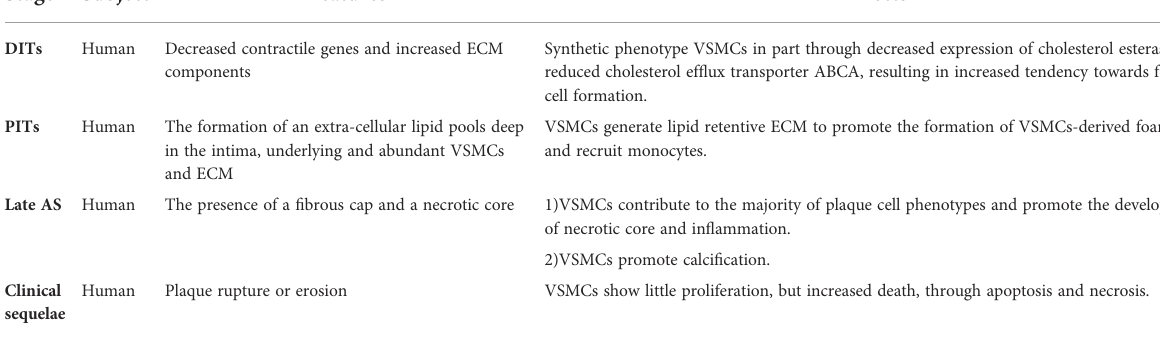
Table 1 VSMCs in different stages of